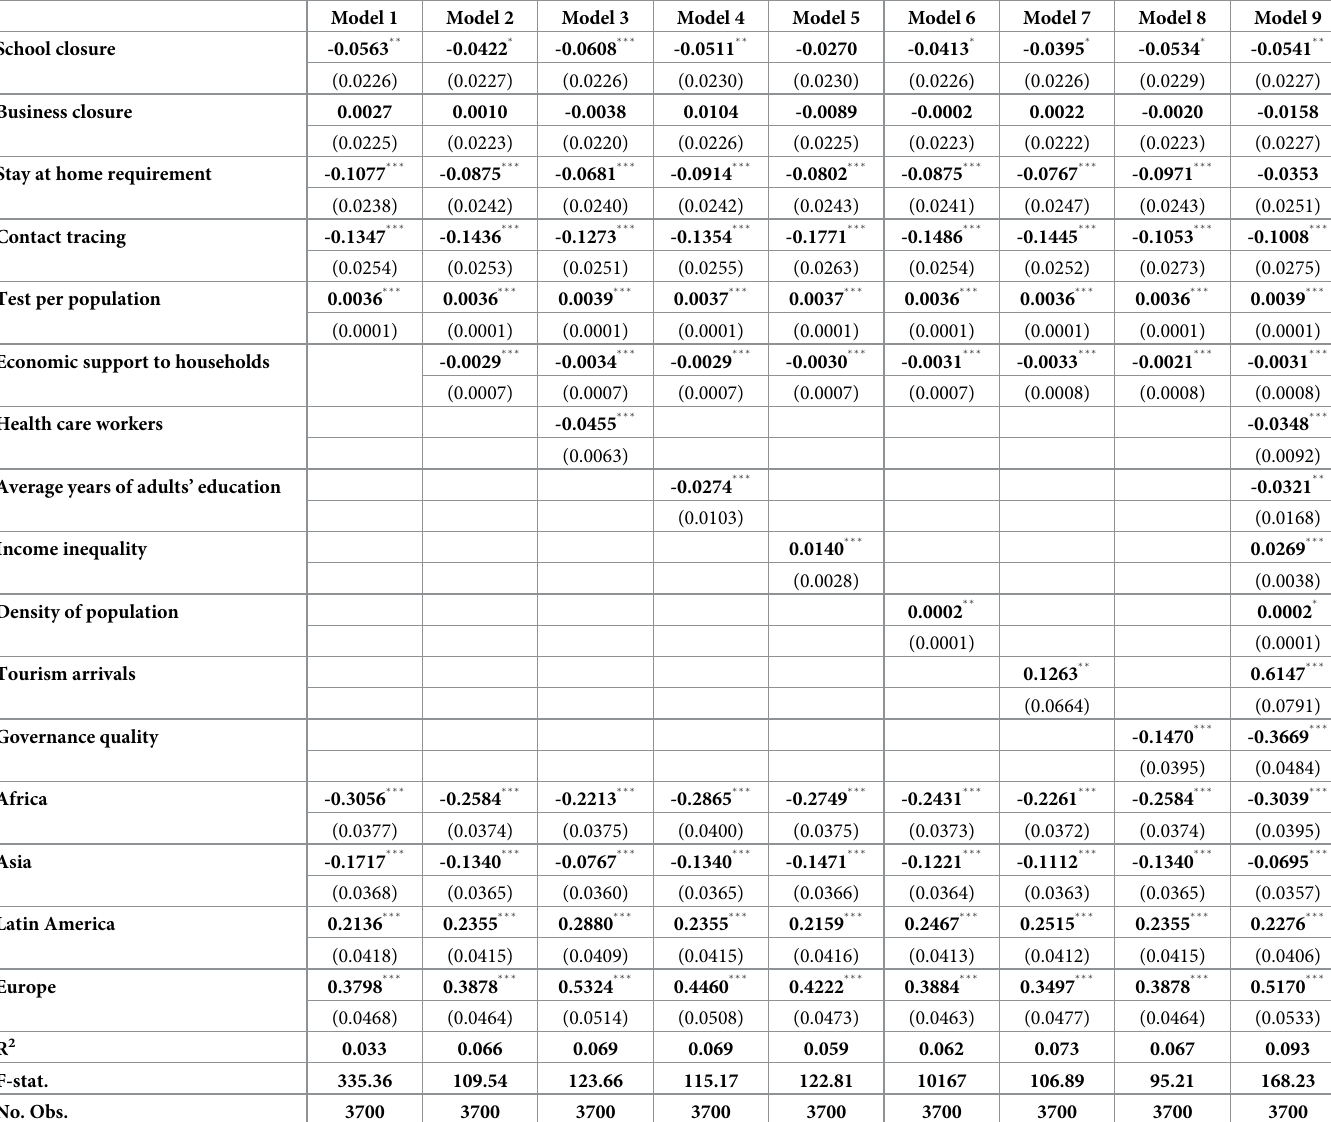
Table 1. The effects of government interventions on COVID-19 infection